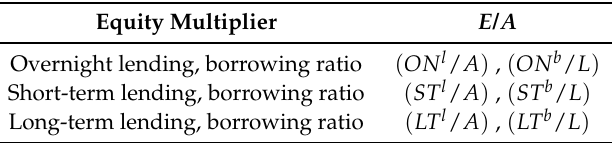
Table 3. Banks’ target ratios.